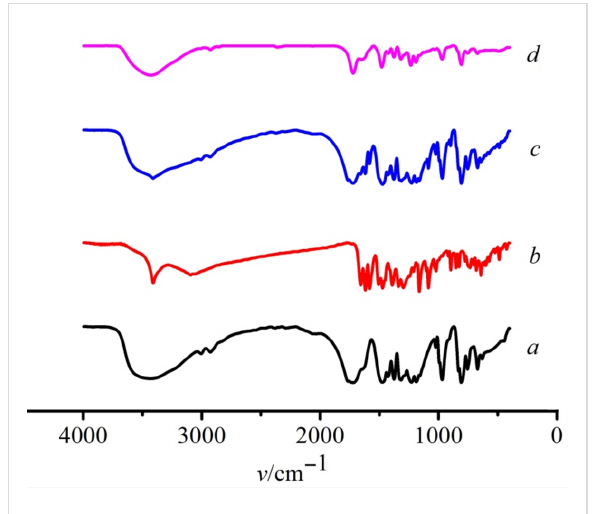
Figure 5: IR spectra of Q[8] (a), BALE (b), a physical mixture of Q[8]-BALE (N Q [8]/N BALE = 1:1) (c) and the BALE–Q[8] inclusion com- plex (d).